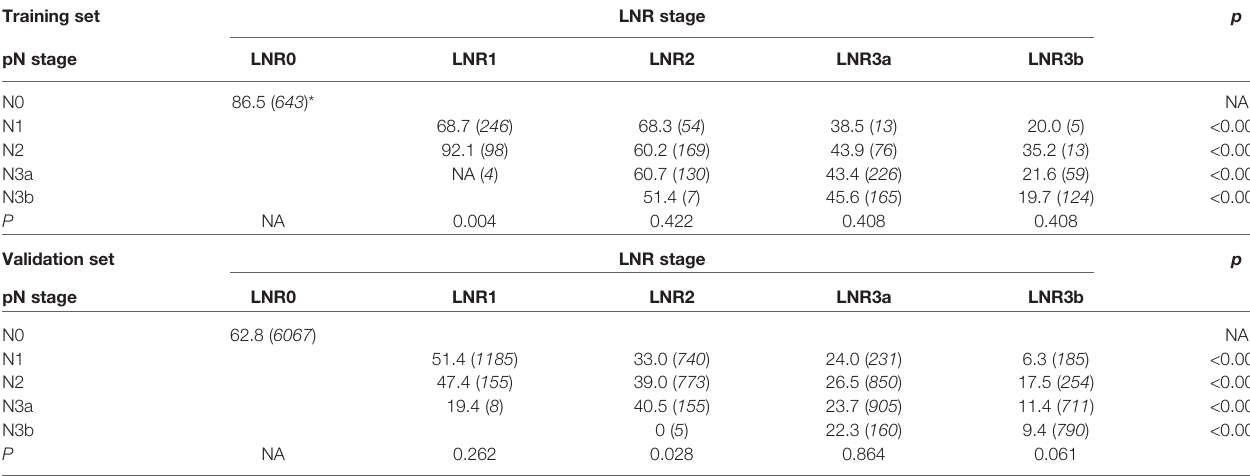
TABLE 3 | Five-Year OS by N Stage and LNR Stage for training set and validation set. Training